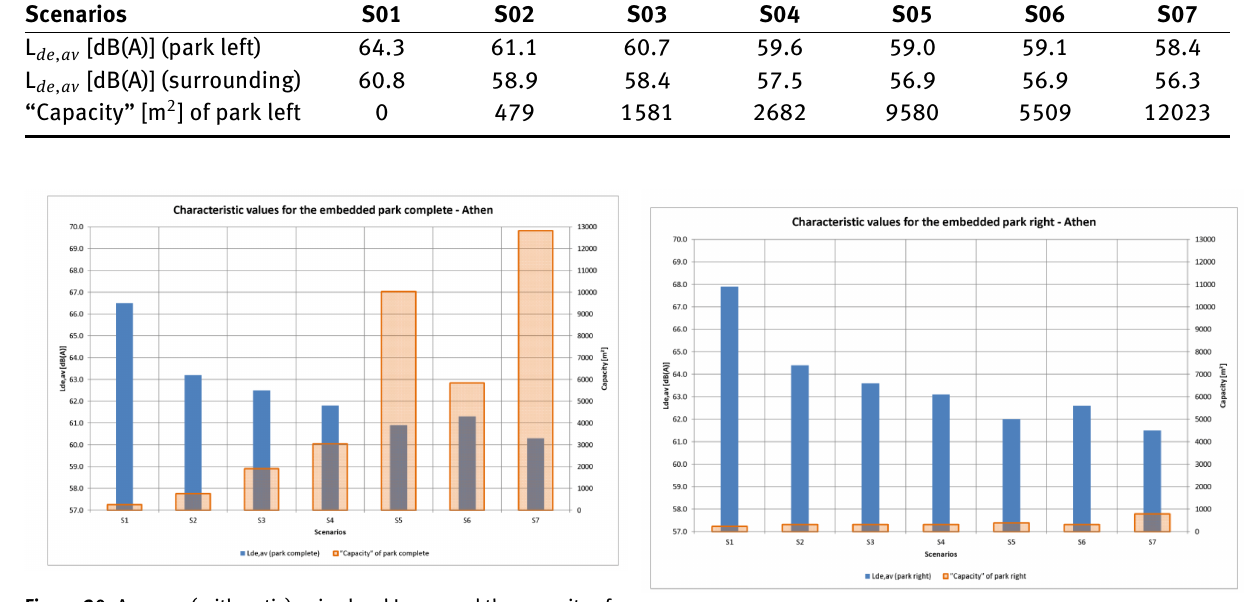
Figure 20: Average (arithmetic) noise level L the complete park in Athens in the various scenario configurations.